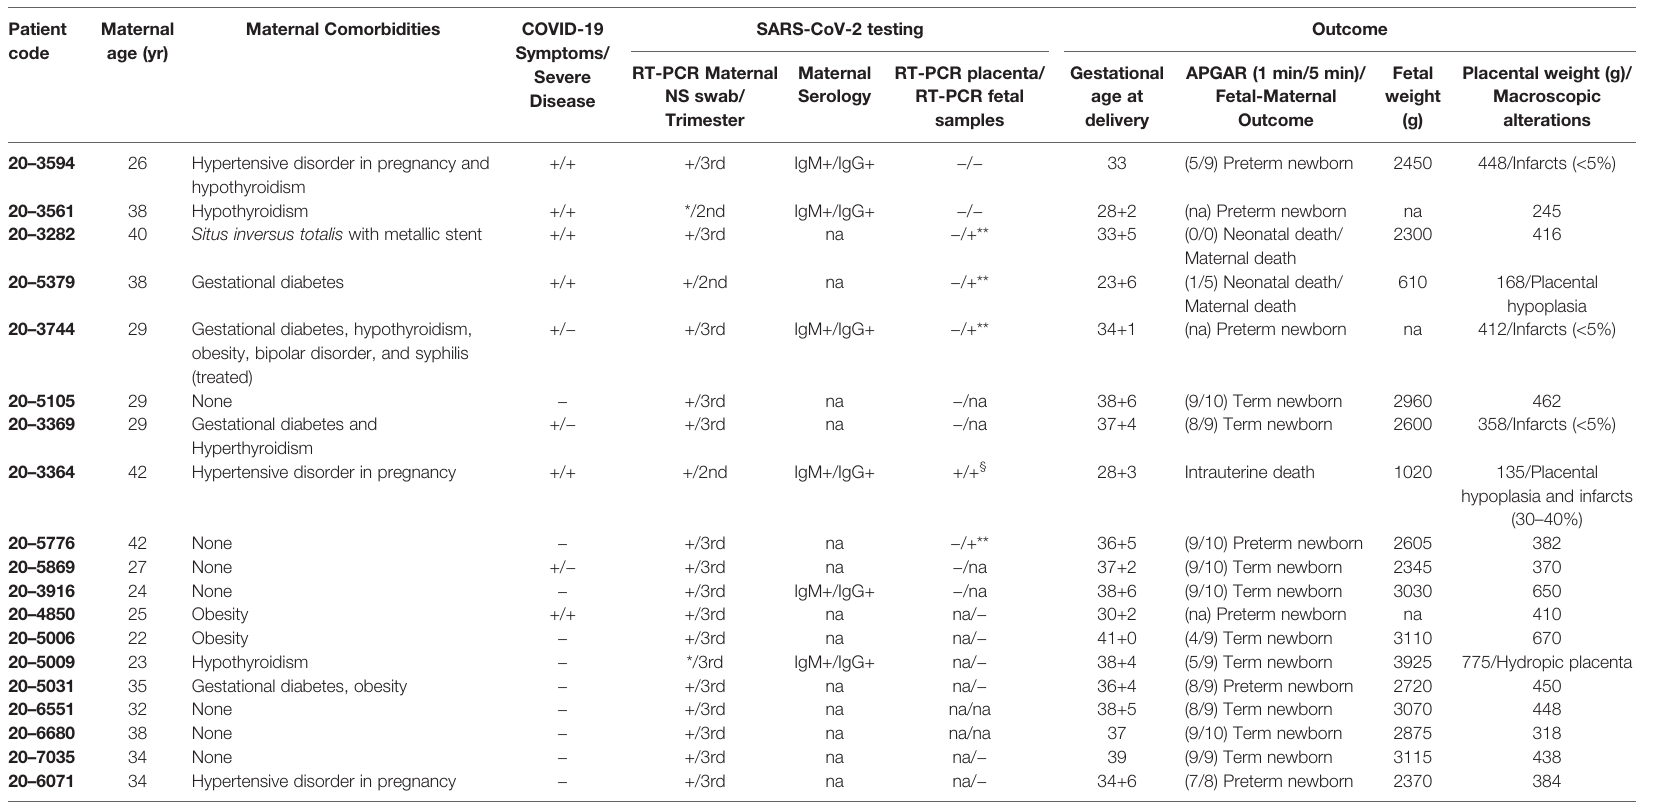
TABLE 1 | Clinical information of the COVID-19